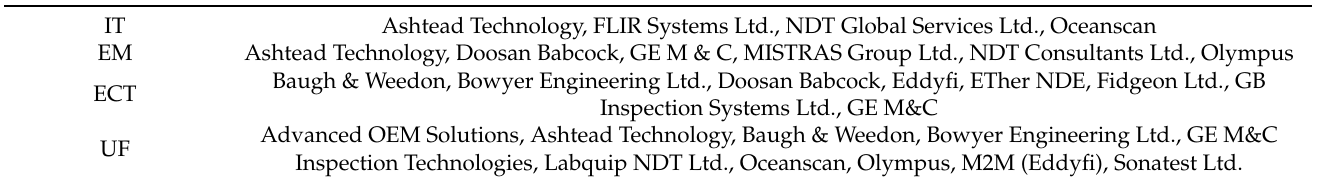
Table 1. Summary of common NDT methods and solutions available in the